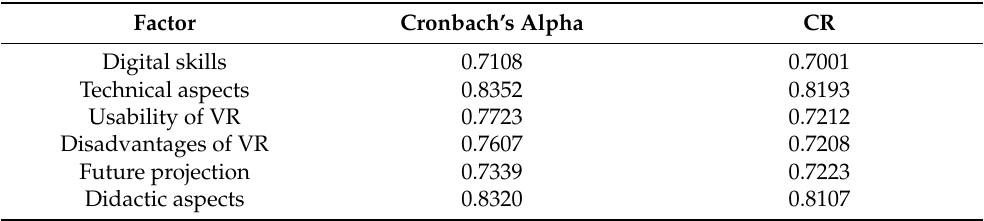
Table 1. Cronbach’s alpha and composite reliability (CR) parameters of the responses to the different families of questions identified by the factor analysis.